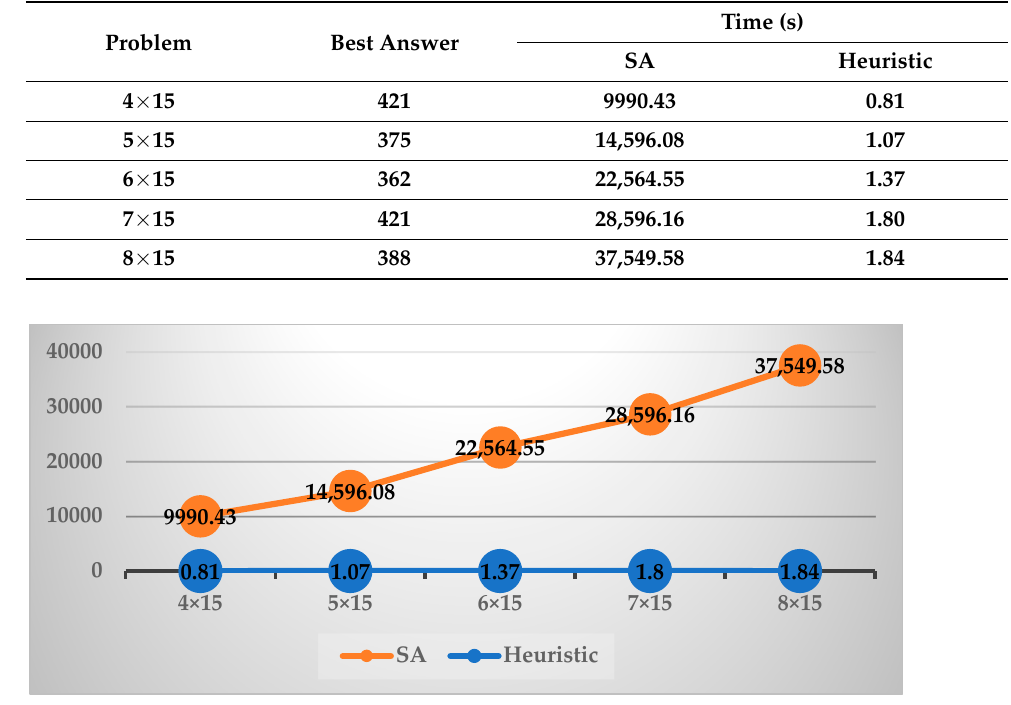
Figure 8. Time-comparison diagram of the SA and heuristic algorithms for different test problems (15 ORs).